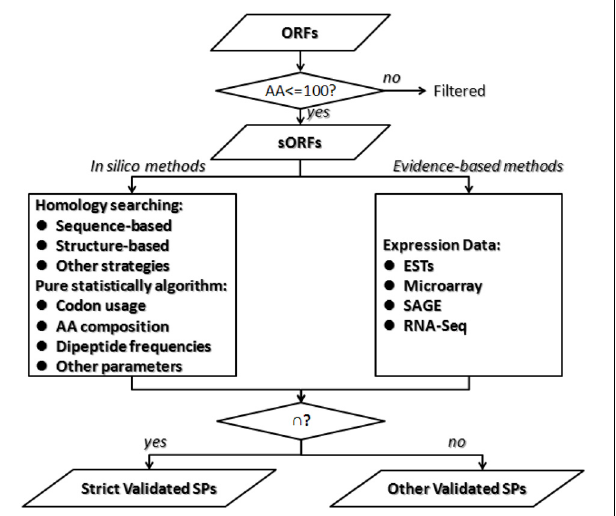
FIGURE 2 | An overview of integrated strategies for small proteins prediction. It is challenge to differentiate meaningful gene-coding sORFs from inutile sORFs because the shorter the protein sequence, the greater the probability of error rate of detection. First we suggest splitting the annotation of SPs from other proteins. Second, it is better to combine both in silico algorithms and evidence-based analysis. Then merge the two parts of results and get two sets of SPs as follows. The strict validated SPs are those validated by both methods, while other validated SPs are those only validated by either in silico algorithms or evidence-based